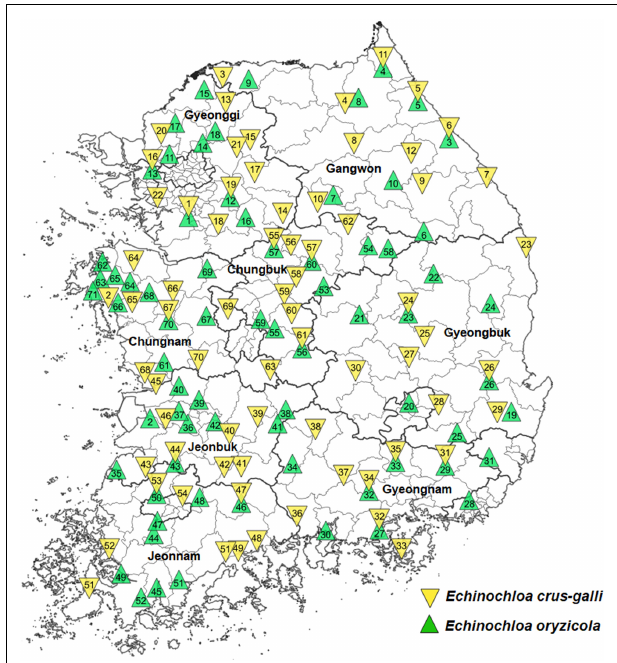
FIGURE 1 | Collection sites of 70 Echinochloa crus-galli and 71 Echinochloa oryzicola accessions in Korea.